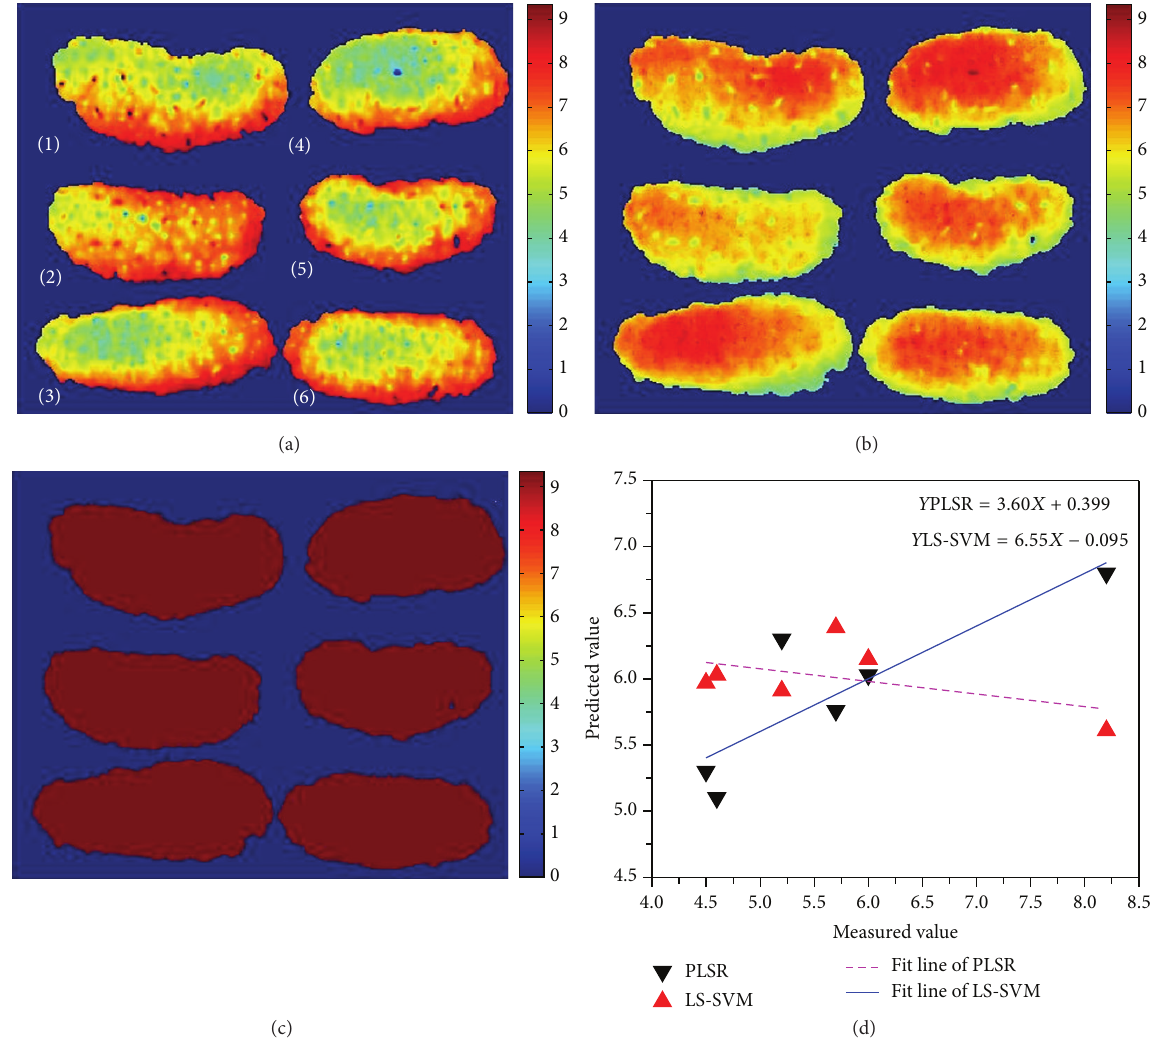
Figure 7: Compared TSS distribution results with PLSR and LS-SVM models: (a) distribution map using PLSR model; (b) visualization result based on LS-SVM model with linear kernel function; (c) TSS distribution using LS-SVM with RBF kernel function; (d) fitting effect between measured and predicted results of PLSR and LS-SVM with linear kernel function. Colour bar represents the TSS